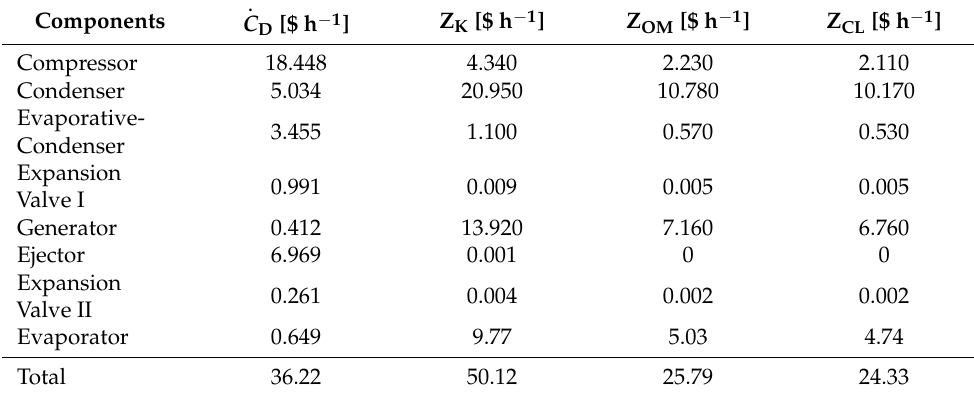
Table 6. Results of conventional exergoeconomic